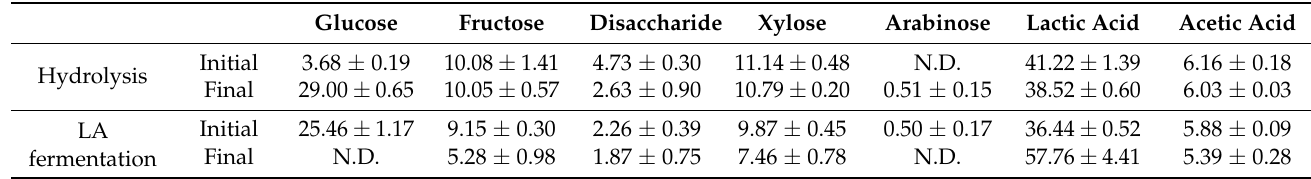
Table 3. The average concentration of sugars, lactic and acetic acid obtained by hydrolysis and fermentation from OFMSW using CE